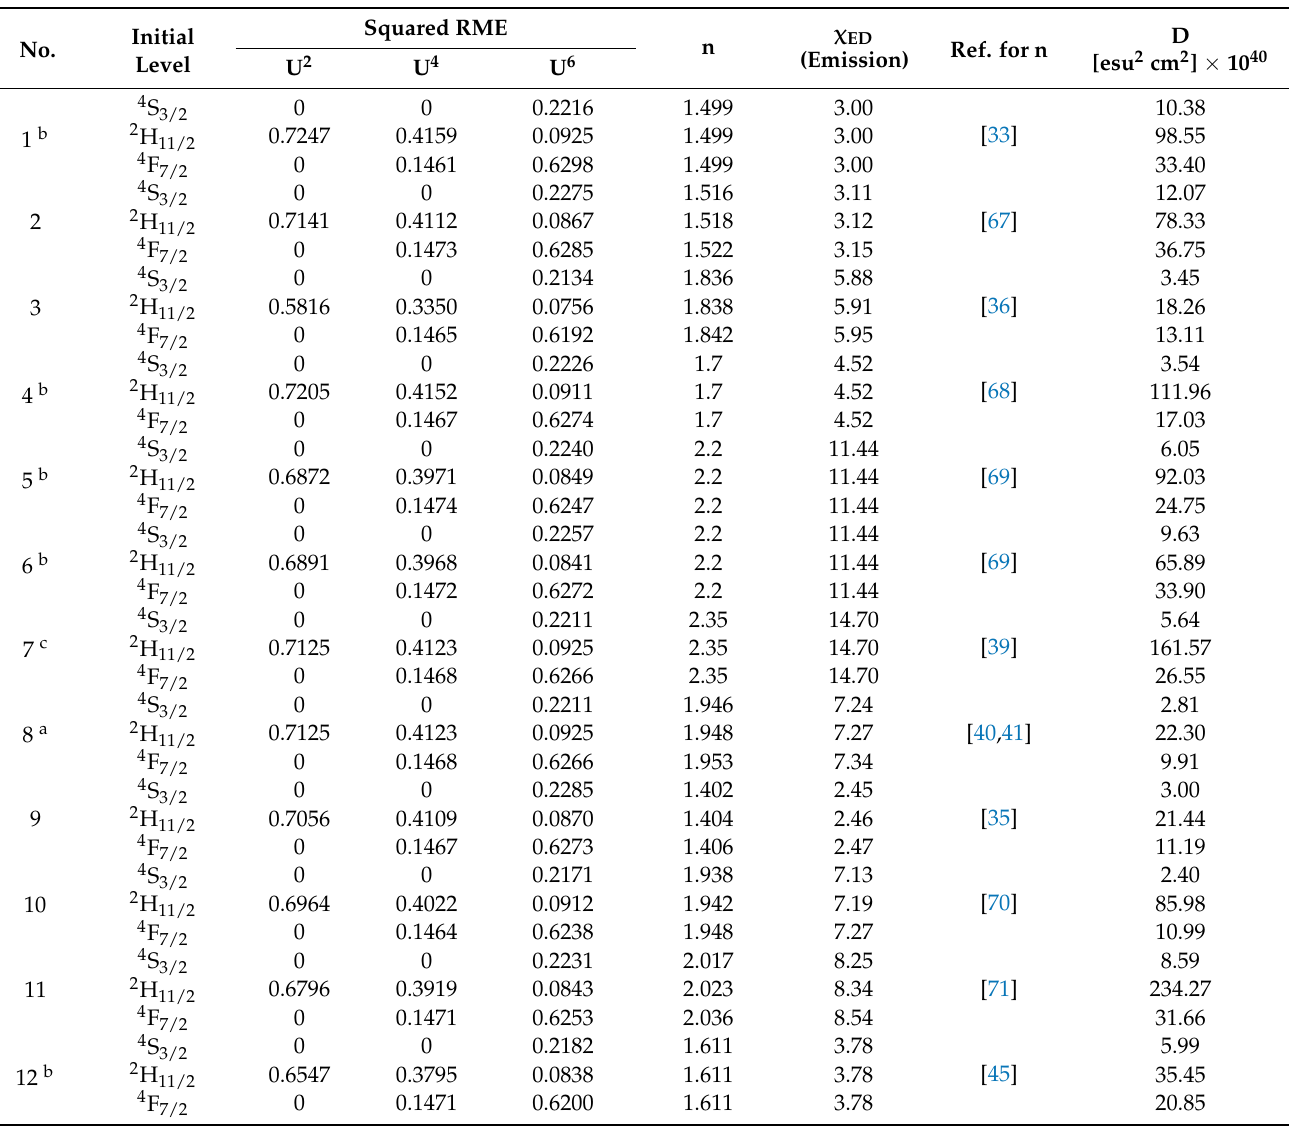
Table 3. Squared RMEs for hosts in Table 1, recalculated by RELIC software [17] from Slater integrals and s–o coupling parameters in Table 2, refractive index values, local corrections for emission, and induced electric dipole strengths. Note: if Slater integrals were not provided in Table 2, the squared RMEs will be given from the tables by Carnall [66], unless indicated that the authors used tables by Weber